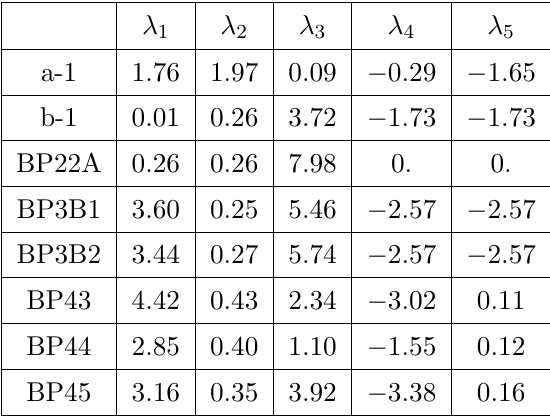
Table 4. Higgs self-couplings for the 2HDM benchmark points outside the alignment limit. We omit the imaginary parts appearing in the CMS.